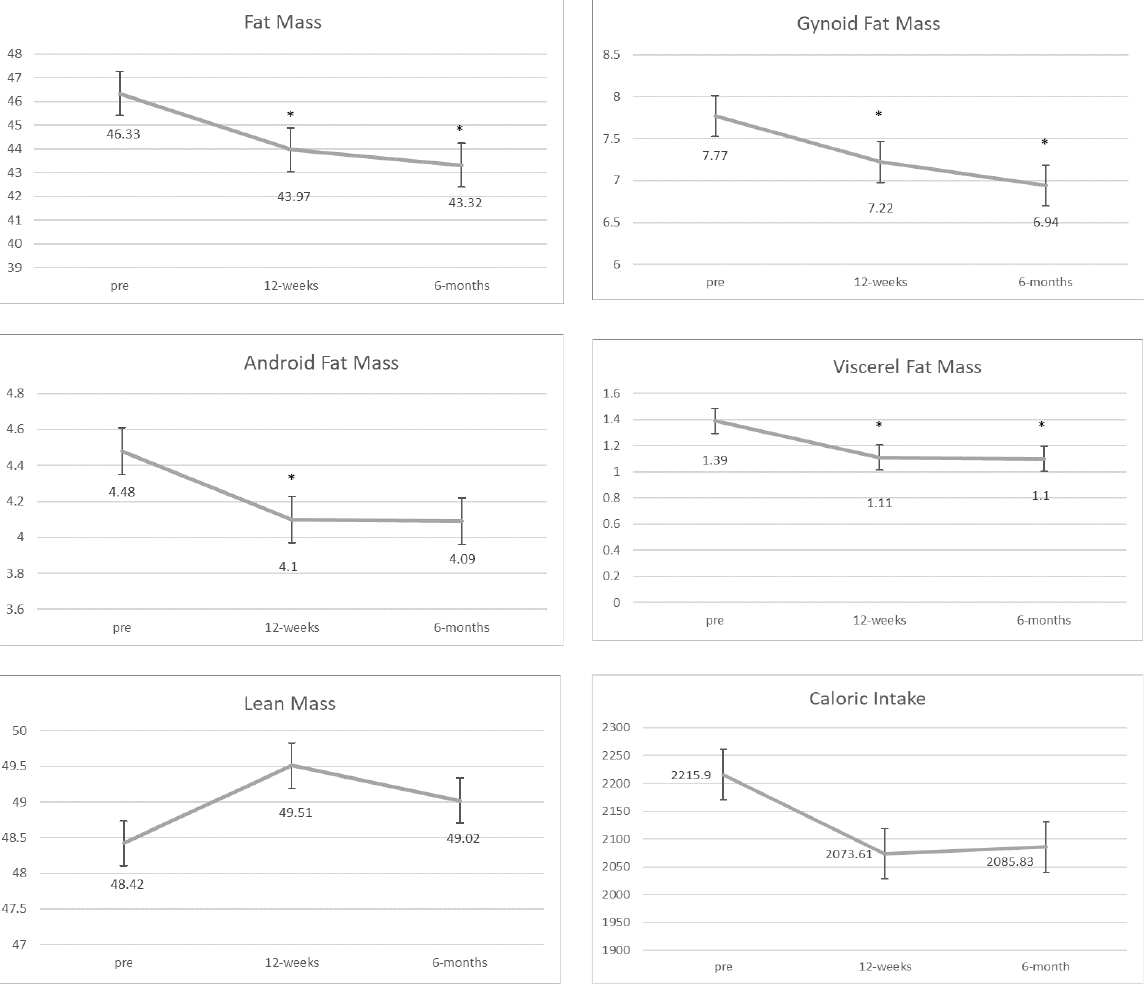
Figure 2. Body composition (kg) and caloric intake at pretest, 12 weeks and 6 months. * p < 0.05 difference is from pretest.